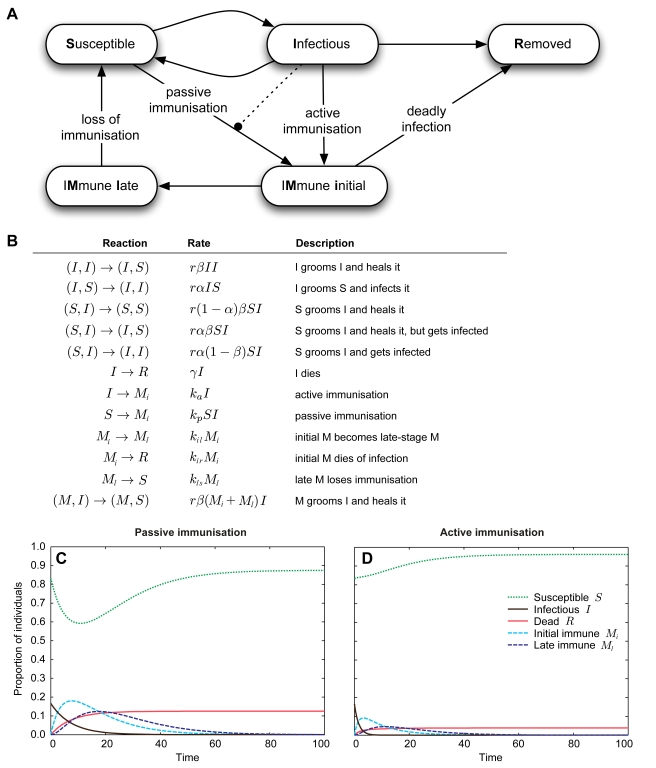
Epidemiological model including two modes of immunisation. Model setup and outcomes.(A) Illustration of the SIRM (Susceptible-Infectious-Removed-iMmune) model, with (B) corresponding state changes and transition rates under which ants change their states. The dotted line in (A) illustrates the influence of infectious individuals (I) on the state change rate from susceptible (S) to initially immunised (Mi) ants for passive immunisation. (C,D) Model predictions for the proportions of individuals in the different states over time, comparing passive (C) and active (D) immunisation. Passive immunisation allows for a higher number of immune individuals (Mi and entering the Ml state, pale and dark blue dashed lines), whereas active immunisation leads to a faster elimination of the disease (infectious [I, black solid line] individuals go to 0) and a lower death rate in the colony (R, red solid line), despite the fact that disease spread from the first exposed ants can only occur in the active immunisation scenario. Immunisation is transient so that Ml individuals become susceptible (S, green dotted line) over time for both passive and active immunisation.